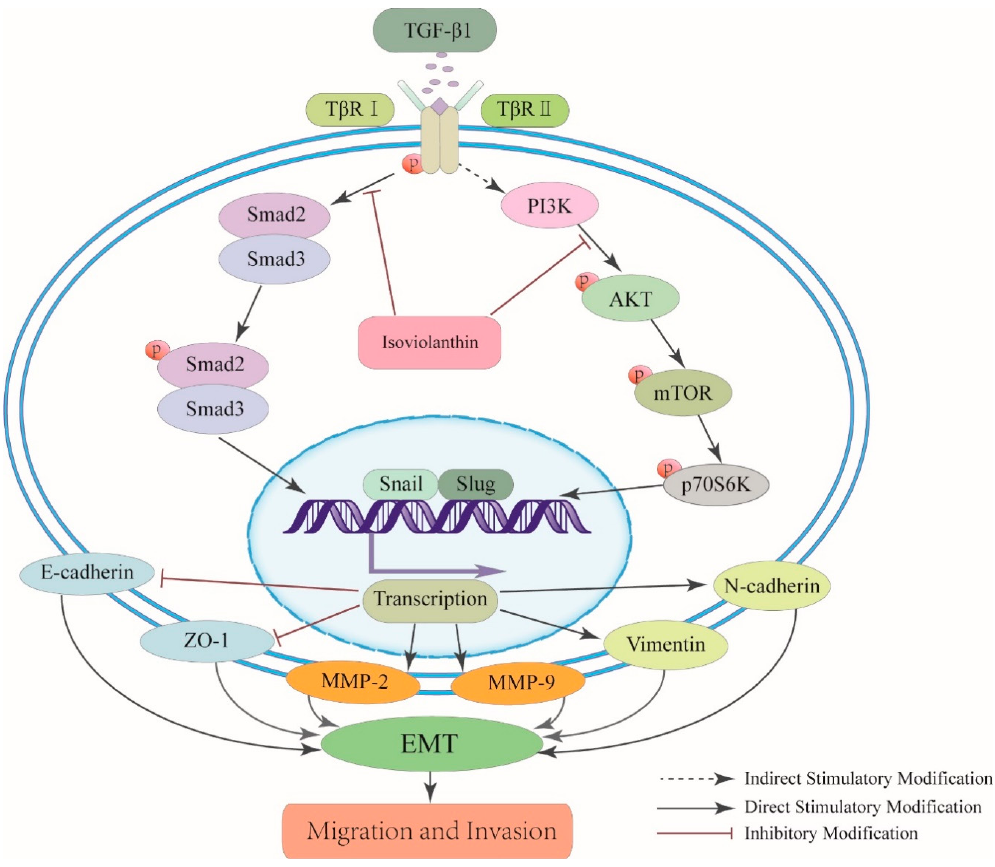
Figure 8. Schematic representation of the effect of isoviolanthin on TGF- β 1-mediated EMT in HCC cells. Isoviolanthin inhibited the TGF- β /Smad and PI3K/Akt/mTOR pathways and finally suppressed HCC cell migration and invasion. “ ↓ ” indicates promotion; “ ⊥ ” indicates inhibition.